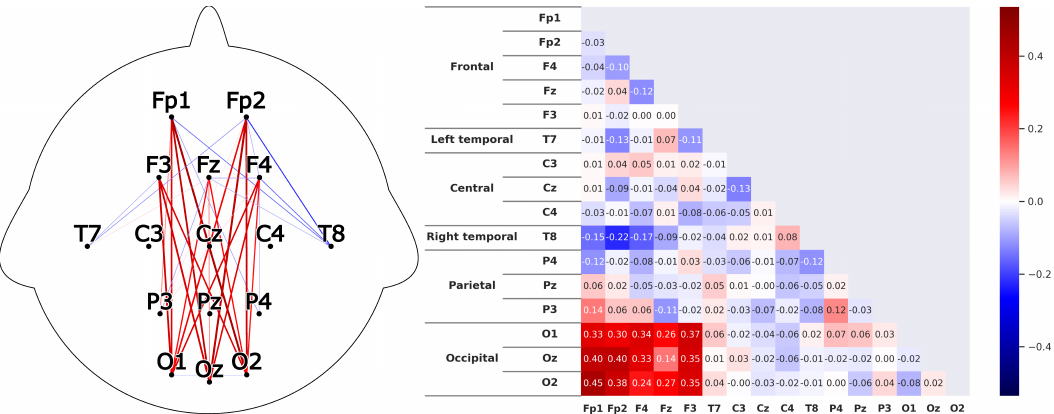
Figure 13. Difference of the results between the BSC leader and the BSC process owner as described in Figure 10.